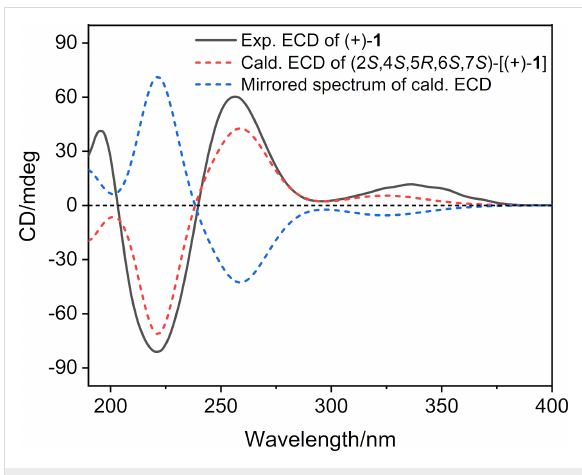
Figure 3: Experimental and calculated ECD curves of (+)- 1 .